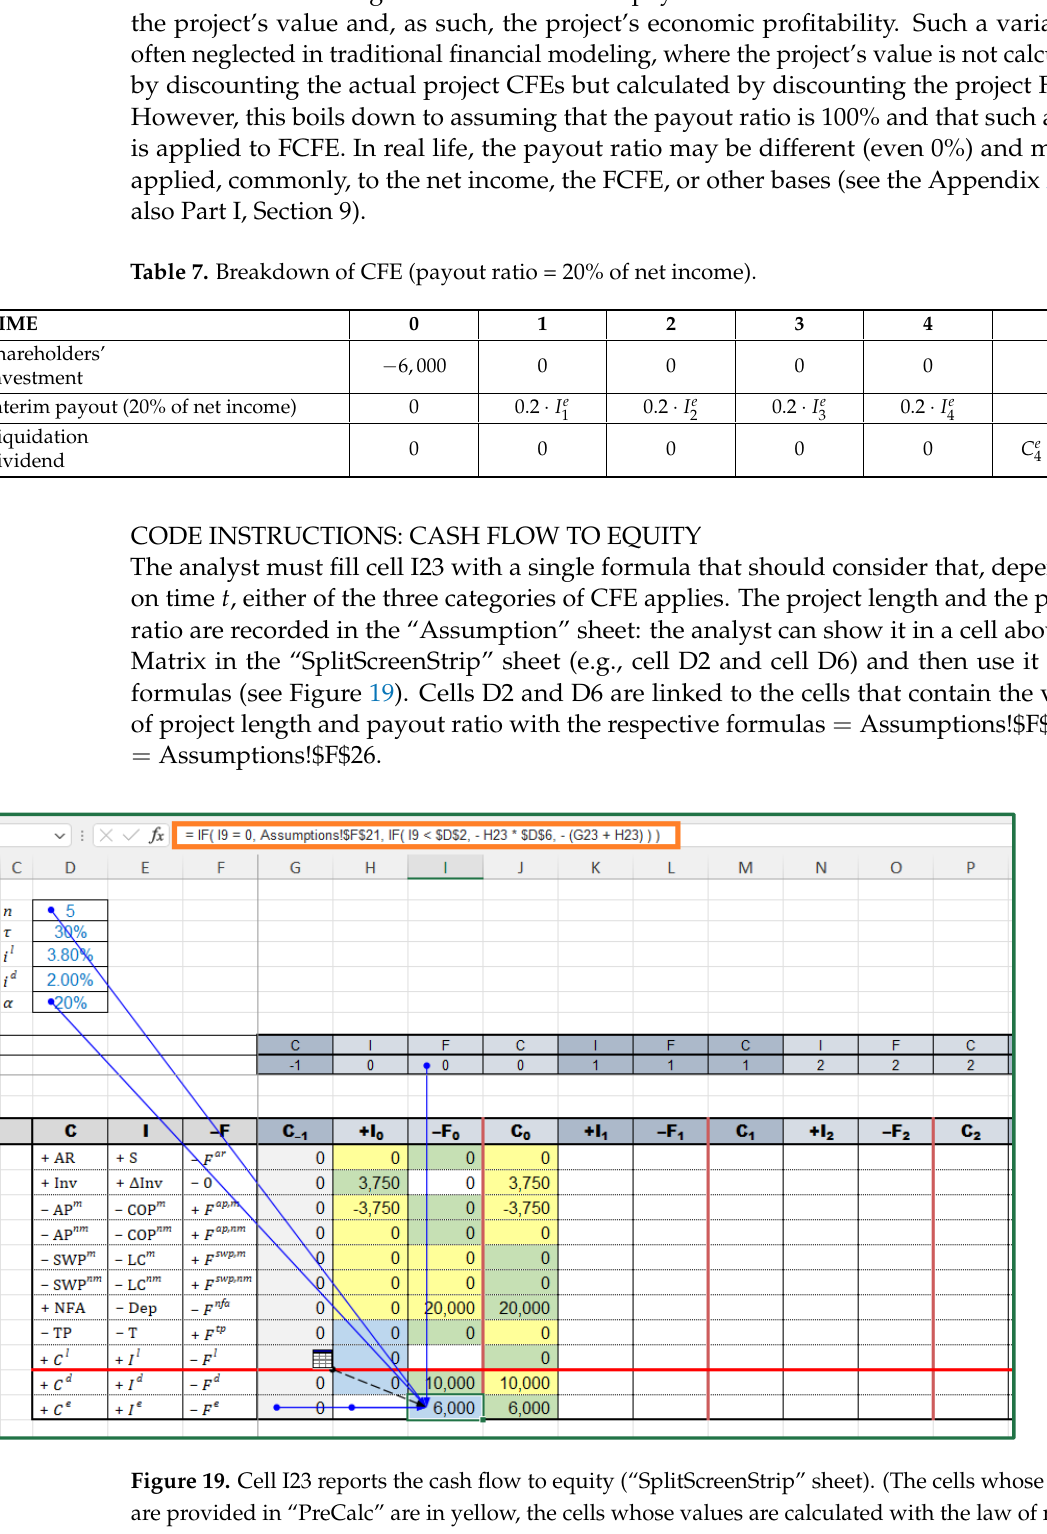
Table 7. Breakdown of CFE (payout ratio = 20% of net income)